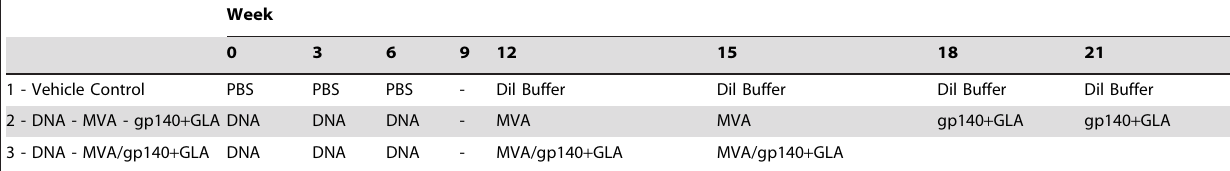
Table 2. Rabbit vaccination